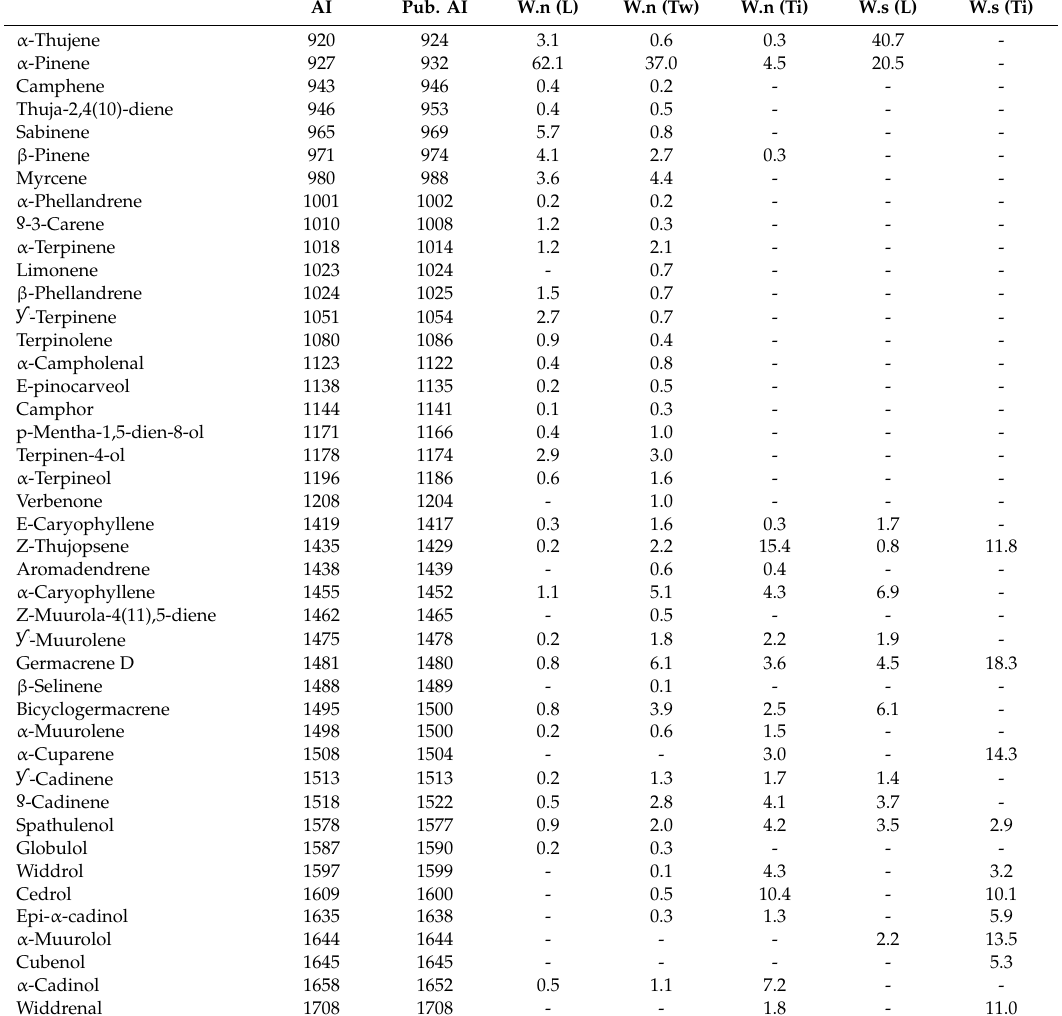
Table 6. Minimum inhibition concentration (MIC) values ( µ g / mL) for compounds 1–2, 4–8, and 10. Sandaracopimaric acid (1), Z -communic acid (2), 12-hydroxy-8 R ,17-epoxy-isocommunic acid (4), 8 S -formyl-isocommunic acid (5), 8 R ,17-epoxy-isocommunic acid (6), 8 R -17-epoxy- E -communic acid (7), 8 R -17-epoxy- Z -communic acid (8), and pisiferic acid (10). The organisms were Staphylococcus epidermidis (ATCC 12228), Staphylococcus aureus (ATCC 29213), Pseudomonas aeruginosa (ATCC 27703), Bacillus Table 1. Yields of isolates 1–12 in % ( g/g ). C.e— Callitris endlicheri , C.c— C. columellaris , W.s— subtilis (University of New England strain), and Escherichia coli (ATCC 25922). Spath = spathulenol Widdringtonia schwartzii , W.c— W. wallichii , W.n— W. nodiflora . (L)—Leaves, (Tw)—Twigs, (Ti)— encapsulated using equimolar concentration of α -cyclodextrin. * Also tested against a methicillin Timber, (C)—cones. Sandaracopimaric acid ( 1 ), Z -communic acid ( 2 ), E -communic acid ( 3 ), 12- resistant Staphylococcus aureus (MRSA) strain, which gave the same MIC value. Tet =